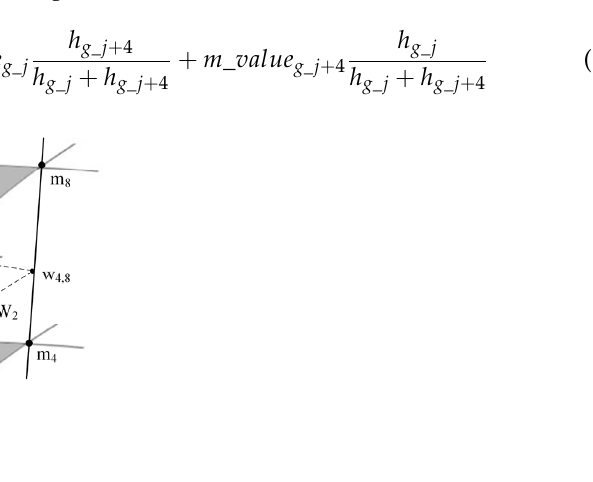
Figure 3. Illustration of 3D mesh interpolation.